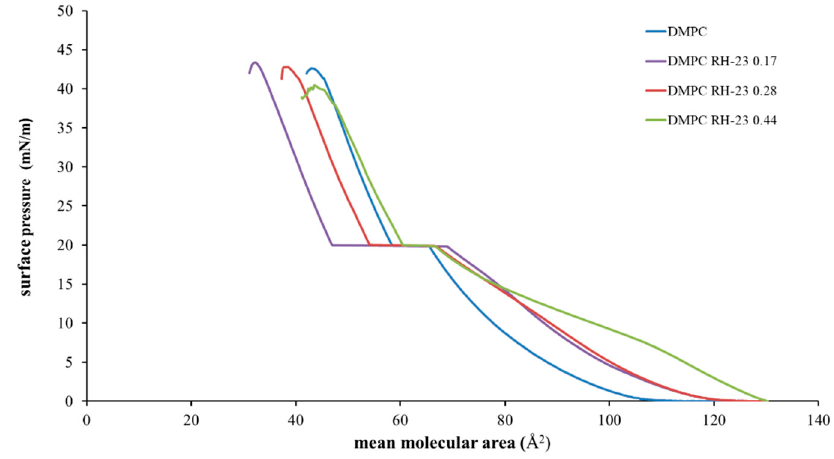
Figure 6. Surface pressure (mN/m)/mean molecular (Å 2 ) isotherms of DMPC monolayers in the presence of RH-23 at different molar fractions in the subphase with a pause of 30 min at 20 mN/m, at a temperature of 37 °C and pH 7.4.